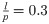
LR from pressure-necessitated EOA reduction.As utilities (dots) in the filtered BDBWUI database increase supply pressures from their initial pressures (x-axis) to 17m, the proposed model suggests that EOA must be reduced. Different EOA reductions are required under scenarios i) and ii) (i.e., a) lp=0.3, and b) lp=0.02). These reductions in EOA are predicted to translate to LR in the intruded volume (y-axis).